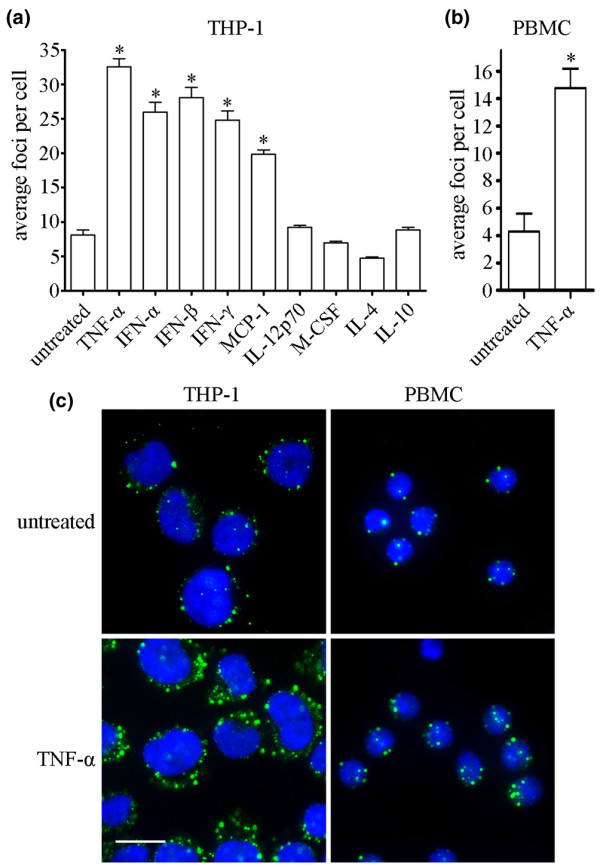
TNF-α treatment results in increased number of GWB in THP-1 and human PBMCs. (a) THP-1 cells were treated with 10 ng/ml TNF-α, IFN-α, IFN-β, IFN-γ, IL-12p70, M-CSF, IL-4, IL-10, or 25 ng/ml MCP-1 for 4 hours. IIF was performed using a human anti-GWB serum to detect GWB, and the number of GWB were counted using CellProfiler image analysis software. Average number of GWB per cell and SEM is shown. *P < 0.0001, as determined by one-way analysis of variance. (b) Human PBMCs were obtained from a healthy donor and isolated using Ficoll density-gradient centrifugation. The cells were then cultured for 4 hours in the presence of 1 ng/ml TNF-α. GWB were detected by IIF using rabbit anti-Rck/p54 antibodies. Average number of GWB and SEM is shown. *P < 0.0001, as determined by Mann-Whitney test. (c) IIF image of THP-1 and PBMCs treated with 10 ng/ml or 1 ng/ml TNF-α for 4 hours, respectively. GWB are shown in green, and nuclei are counterstained with 4',6-diamidino-2-phenylindole (DAPI; blue). Bar = 10 μm. GWP, GW or P bodies; IL, interleukin; IFN, interferon; IIF, indirect immunofluorescence; MCP, macrophage chemoattractant protein; M-CSF, macrophage colony-stimulating factor; PBMC, peripheral blood mononuclear cell; SEM, standard error of the mean; TNF, tumor necrosis factor.